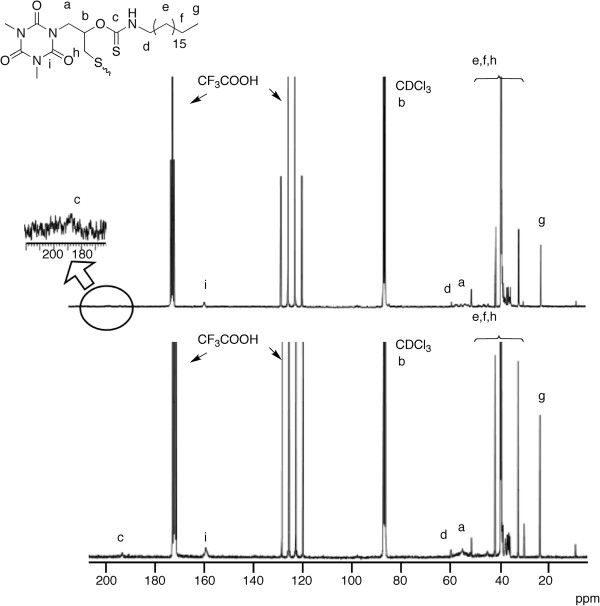
13C-NMR spectrum of OTSH and OTZnS (100 MHz, CDCl3/CF3COOH (v/v = 5:1)). The assignment of the signals (a-i) is indicated on the structures.